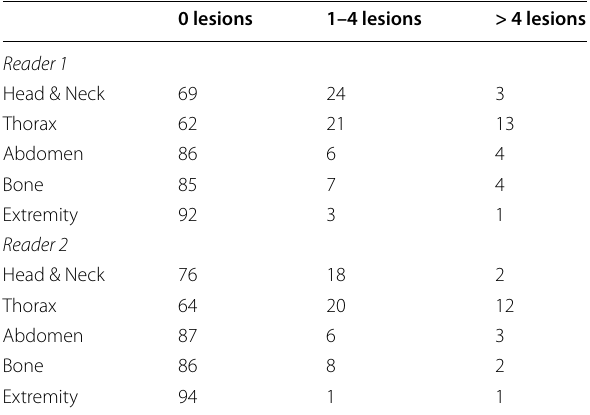
Table 4 Analysis of 480 body‑region classifications: reader 1 and